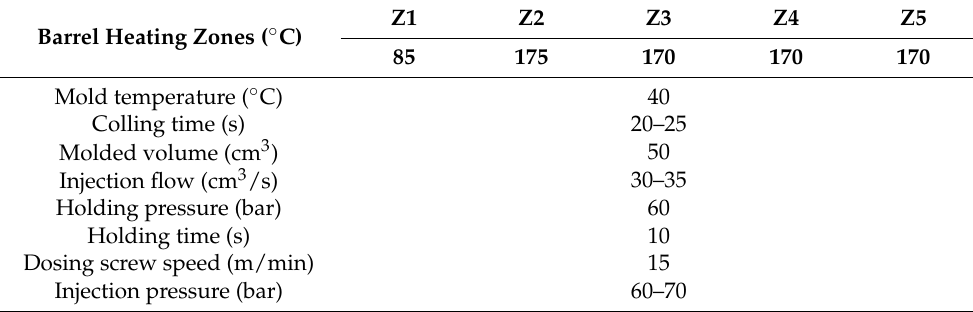
Table 4. Injection molding process parameters.